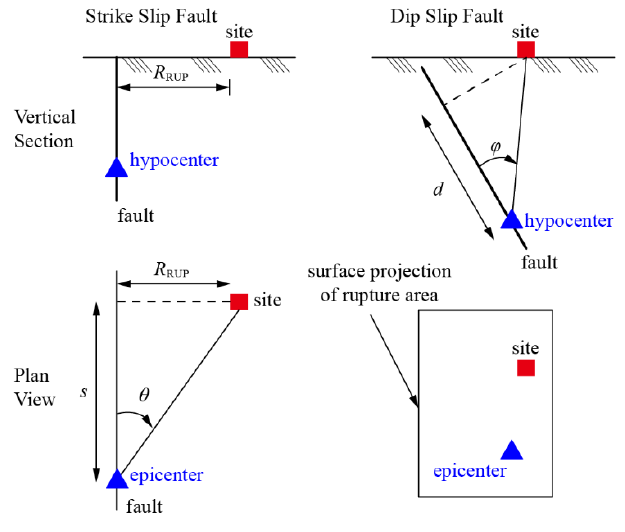
Figure 1. Directivity parameters [47].